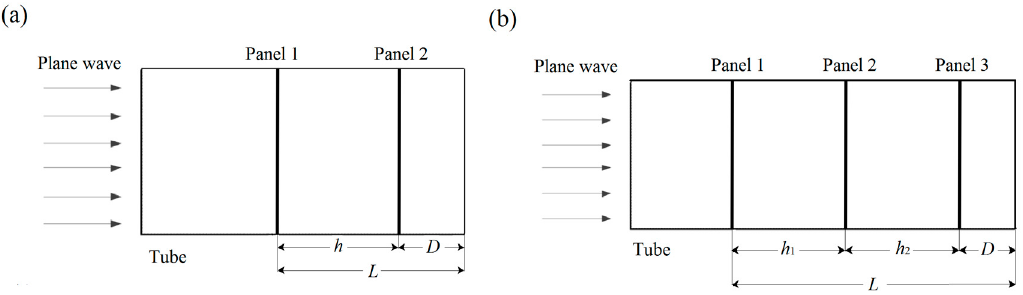
Figure 4. The schematic demonstration of the multi-layer MPPs: ( a ) a double-layer MPP and ( b ) a triple-layer MPP in the impedance tube.